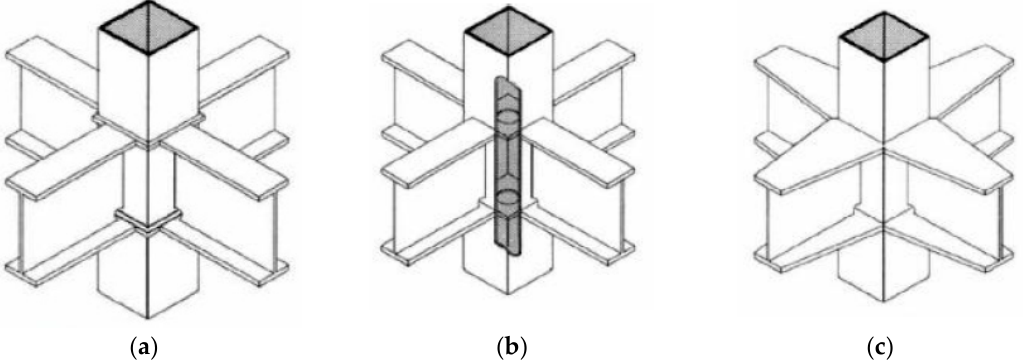
Figure 1. Typical H-section beam to hollow structural section (HSS) column diaphragm connections [16], with permission. ( a ) Through-diaphragm; ( b ) internal diaphragm; ( c ) external